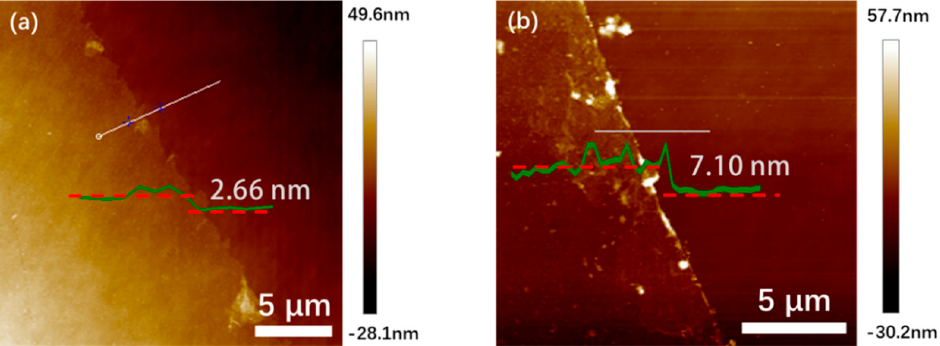
Figure 6. The film thickness of h-BN on substrates with different reaction times. ( a ) 11 min, ( b ) 15 min.